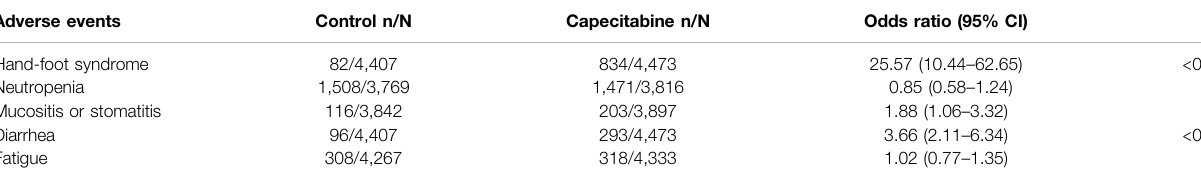
TABLE 2 | Analysis of grade adverse